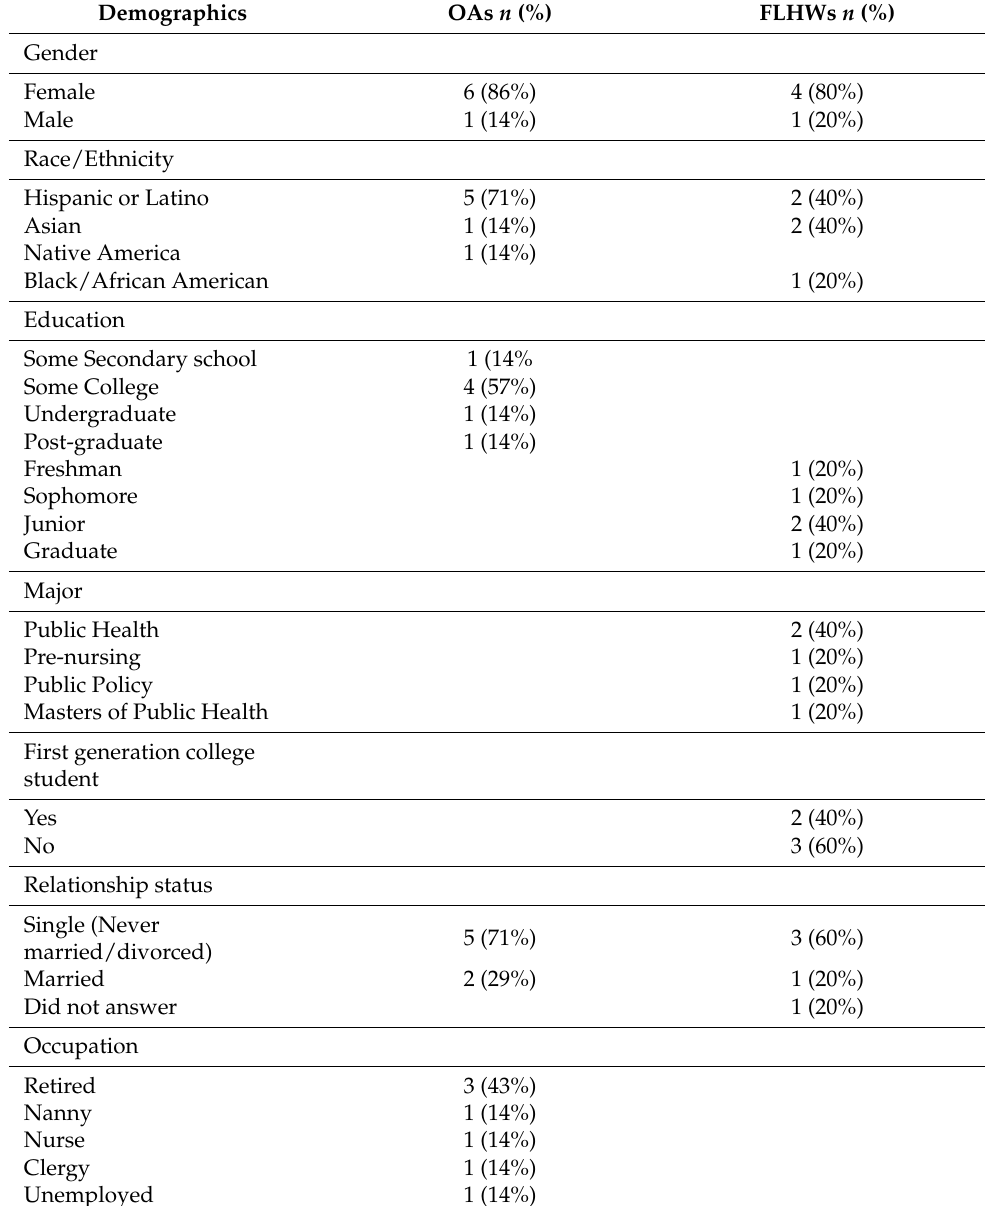
Table 1. Demographic description of Black, Indigenous, and persons of color (BIPOC) older